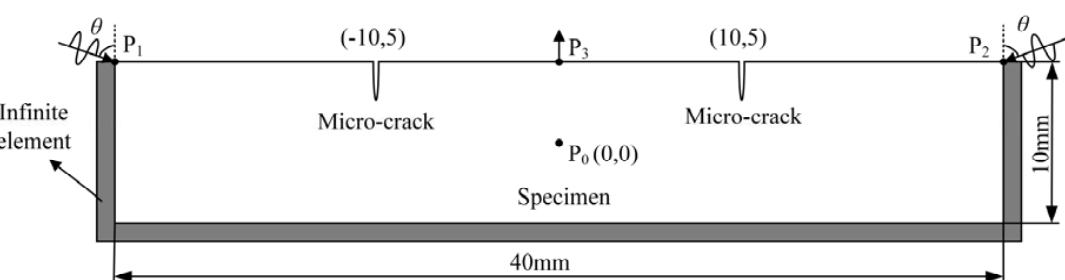
Figure 1. Finite element simulation model for testing the method of exciting reversed-phase Rayleigh waves in opposite directions to measure β .